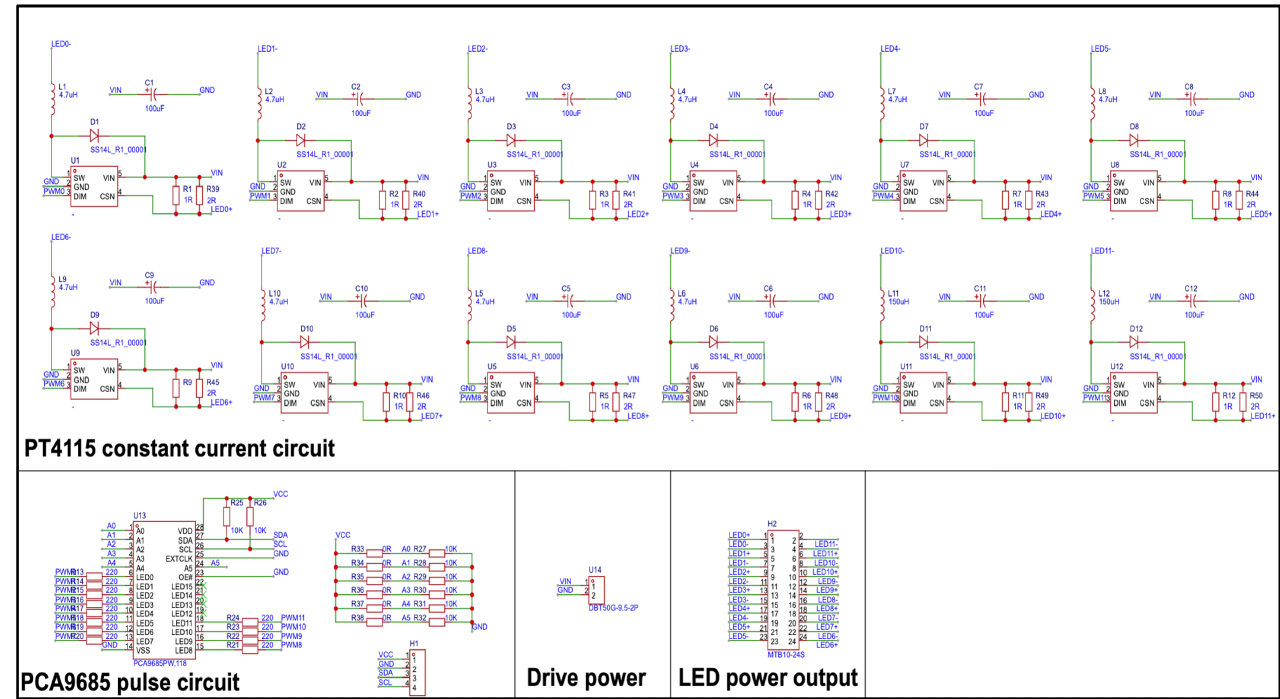
Figure 4. The dimming